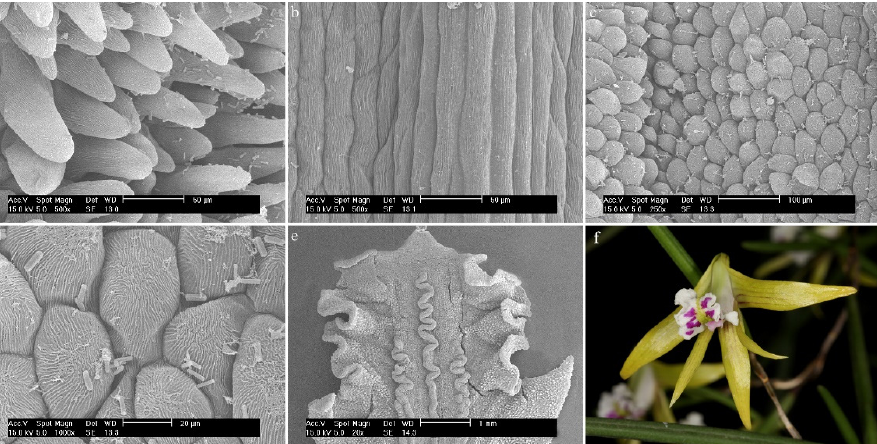
Figure 18. Dendrobium mortii F.Muell.: ( a ) trichomes of the hypochile part of the labellum; ( b ) the hypochile part of the labellum; ( c , d ) the mesochile part of the labellum; ( e ) the epichile part of the labellum with trichomes in the margin; ( f ) flower (photo by John